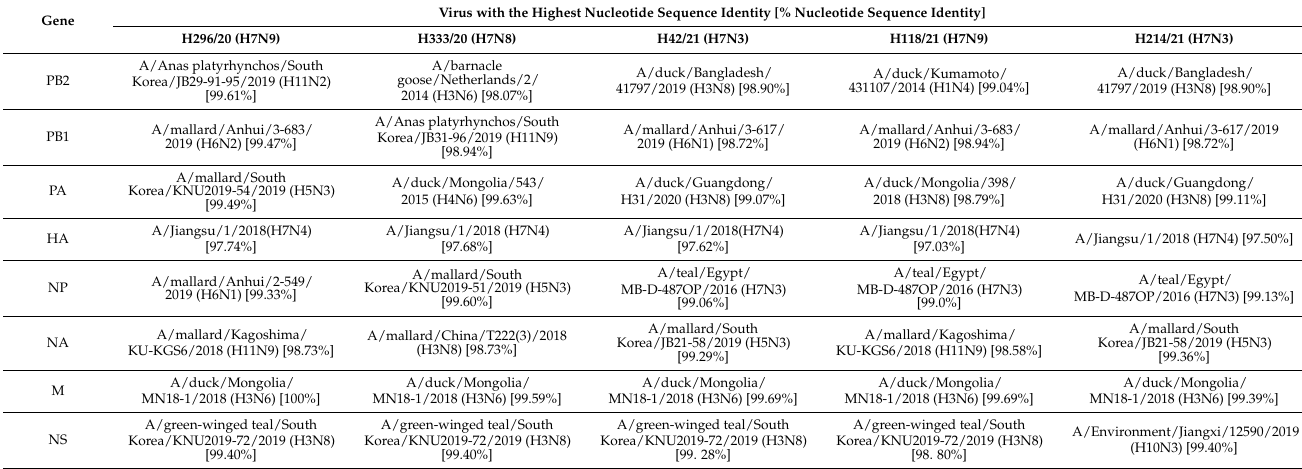
Table 2. Nucleotide identity of near homologs in GenBank and GISAID related to the isolates.